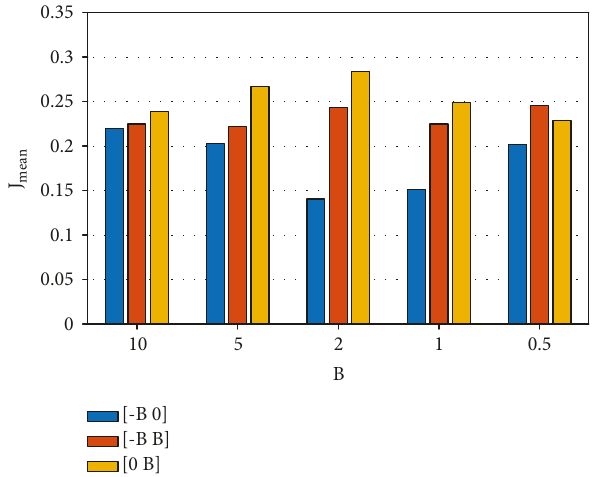
Figure 4: The mean value of the quality J mean of the algorithm as a function of the absolute value of the lower and upper bounds of frequency for Griewank function.